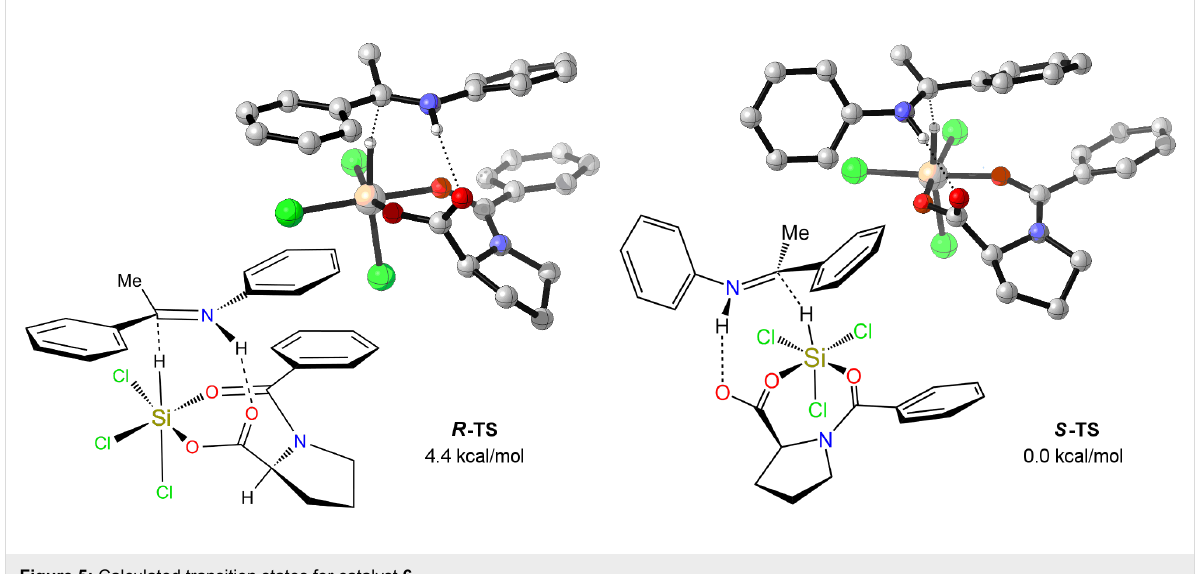
Figure 5: Calculated transition states for catalyst 6 .